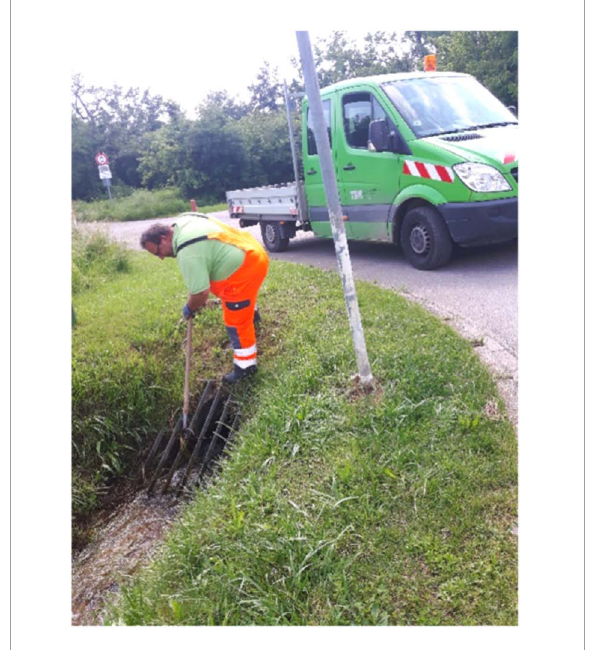
FIGURE4 Technician cleaning the grid of the entry of the culverted section of an urban stream. Photograph: Karl M.